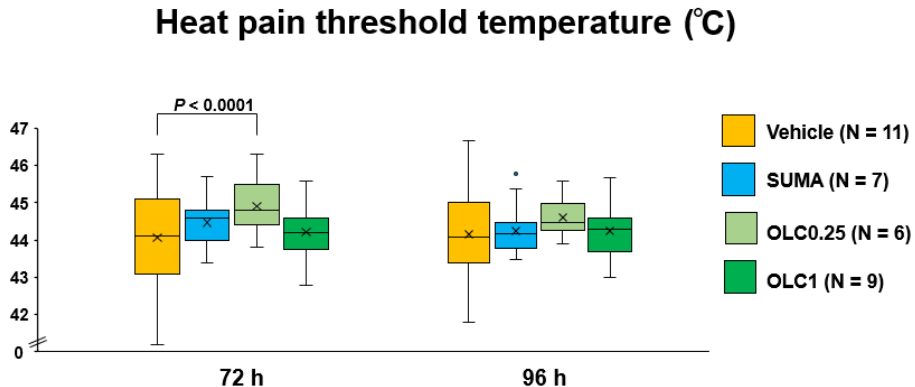
Figure 2. Facial heat pain threshold temperatures after CSD. The ordinate indicates facial heat pain threshold temperature (°C). Data are shown in the box-and-whisker plot. In all mice, measurements were repeated five times at each timepoint. The two-way repeated measures ANOVA were used to evaluate the effects of time and pharmacological interventions on post-CSD facial heat pain threshold temperature. Multiple comparisons were made by Sidak’s test. Vehicle: Vehicle group, SUMA: Sumatriptan group, OLC0.25: Olcegepant 0.25 mg group, OLC1: Olcegepant 1 mg group. The number of animals used are shown in